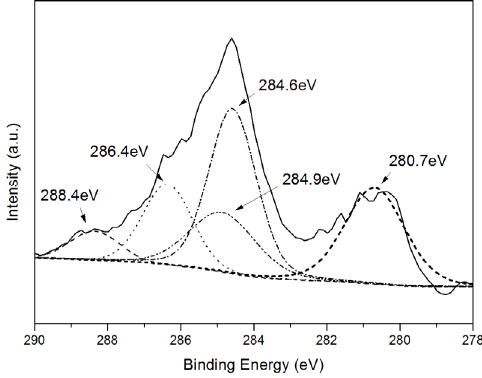
Figure 2. Ru (3d) X ‐ ray photoelectron spectroscopy (XPS) spectrum of the Ru 0.07 TiO 2 .